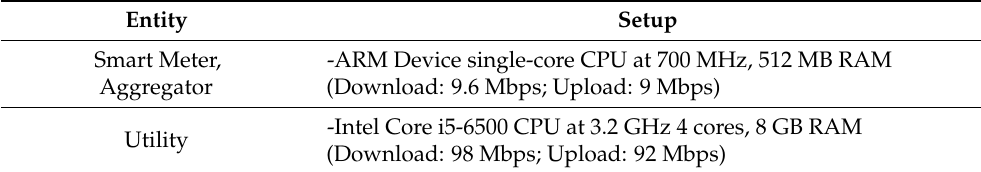
Table 5. SAMGRID testbed parameters for